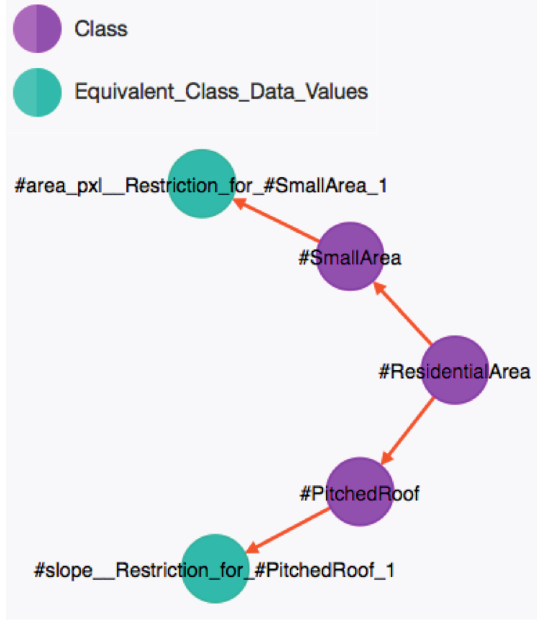
Figure 6. Visualized example of extracted restrictions for a classification concept.